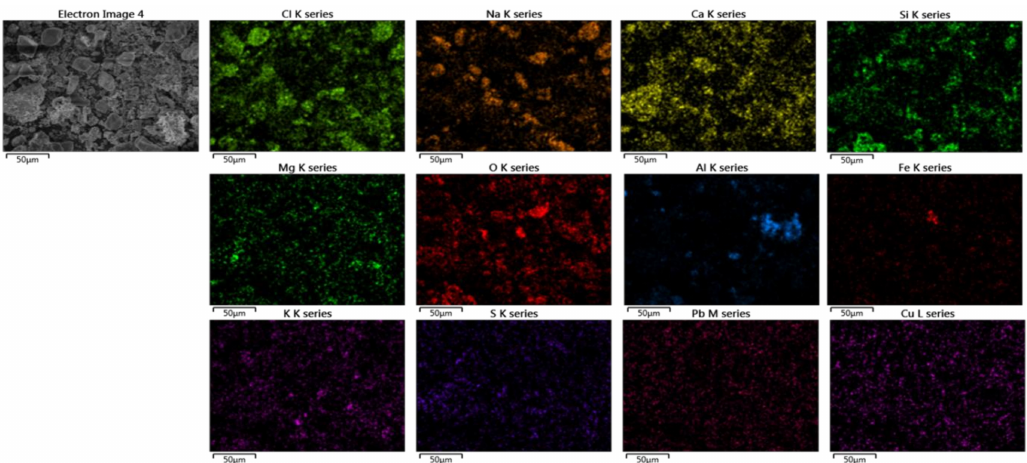
Figure 3. EDS mapping of fly ash 1.